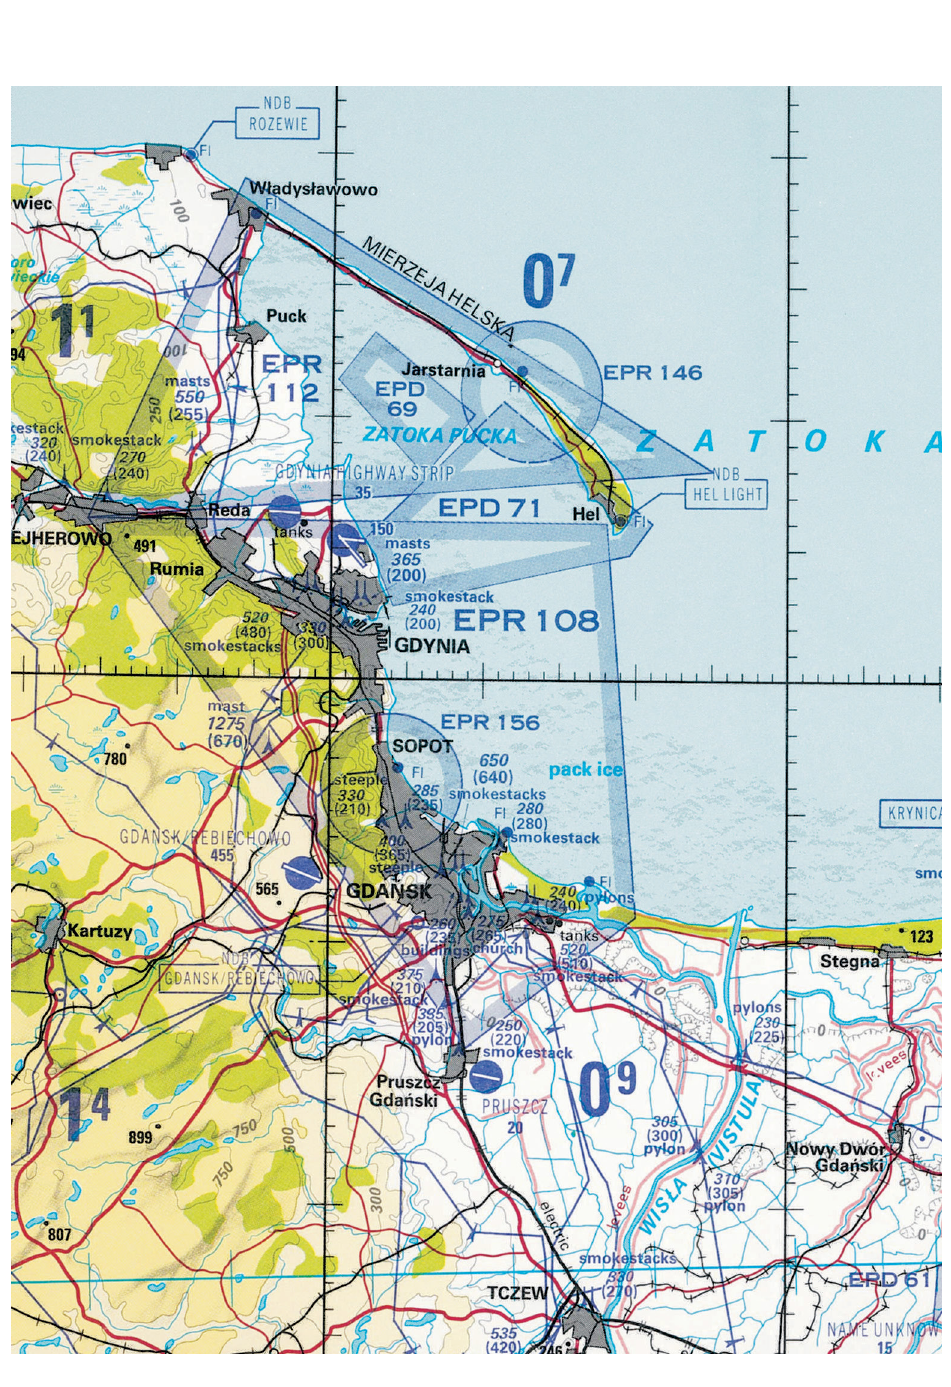
Fig. 13. Tactical Pilotage Chart , 1:500,000 – TPC